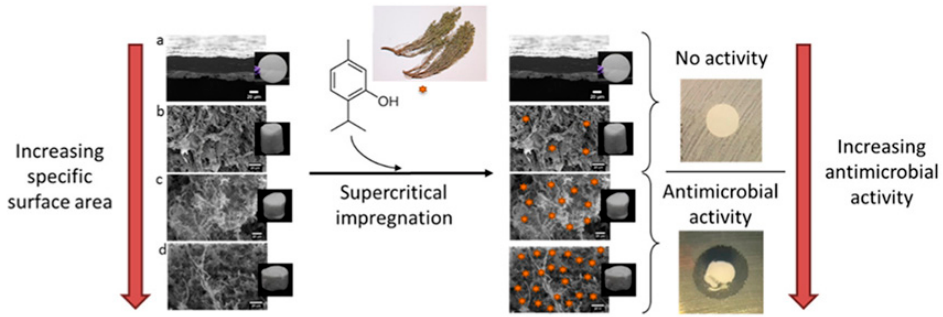
Figure 9. Relationship between the specific surface area and the corresponding antimicrobial prop- erties. (Reproduced with the permission from Ref. [151]. Copyright © 2020 American Chemical Society). ( a ) thymol-impregnated cellulose nanofibrils (CNFs), ( b ) cryogel obtained by freeze-drying the CNF suspension in water, ( c ) cryogel obtained by freeze-drying the CNF suspension in butanol, and ( d ) aerogel obtained by supercritical drying.